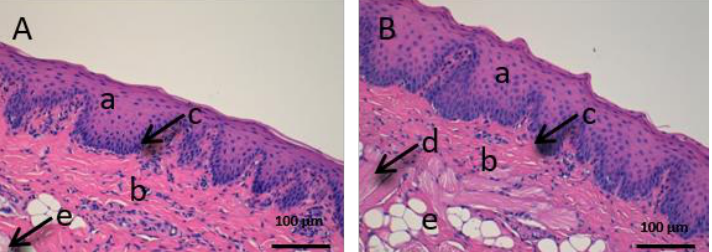
Figure 7. Histological images of buccal mucous. ( A ): Untreated buccal mucous observed at 400x and ( B ): Buccal mucous treated with CP-Sat observed at 400×. a: stratified flat keratinized epithelium; b: own laminate; c: dermal papilla; d: basal layer and e: buccal mucous.